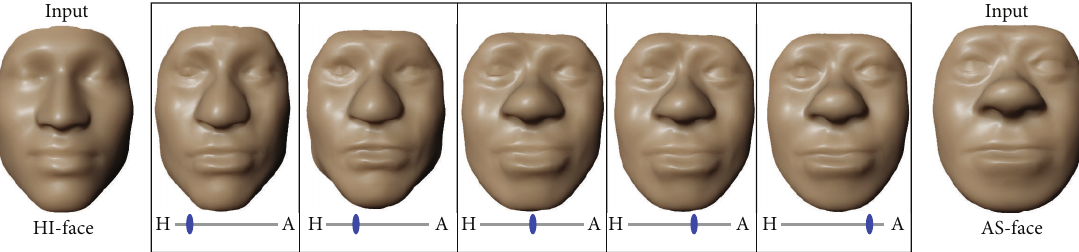
Figure 5: Results by varying the value of the slider control.